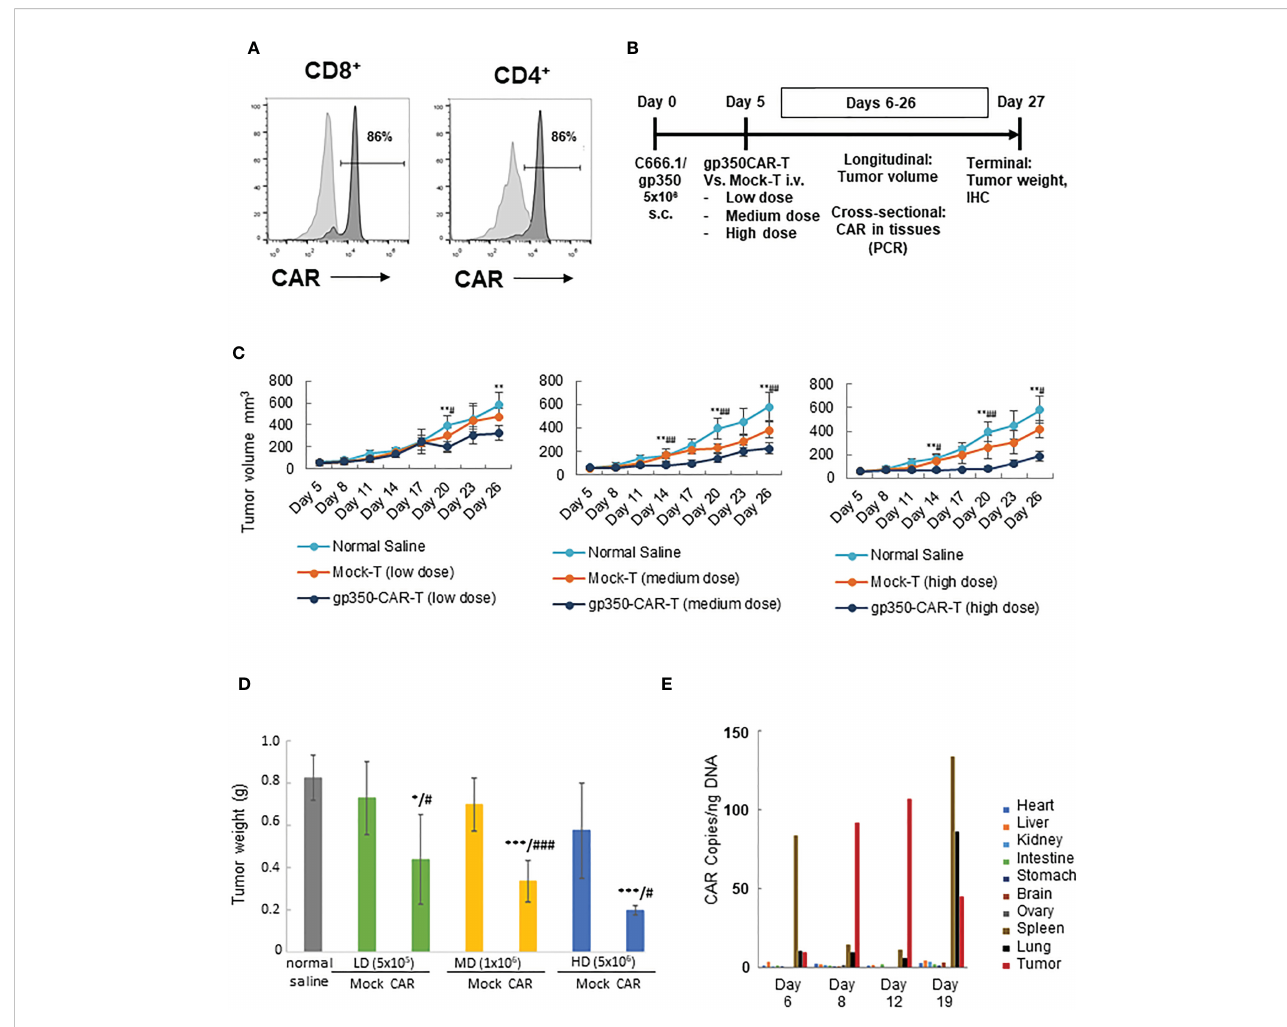
FIGURE 4 In vivo testing of gp350CAR-T cells in B-NDG mice challenged with NPC. (A) Flow cytometry analyses of GMP-like gp350CAR-T cells used for in vivo experiments showing high frequencies of gp350CAR + CD8 + and CD4 + T cells. (B) Schematic representation of in vivo experiment. Mice were injected with 5x10 6 NPC EBV + C666.1/gp350 cells s.c. Five days later, mice were injected with saline, mock-T or CAR-T cells at escalating cell doses. Longitudinal, cross-sectional and terminal analyses were performed to follow tumor growth, CAR-T cell bio-distribution and therapeutic speci fi city. (C) Longitudinal analyses of tumor volume (mm 3 ). Left graph: low T cell dose (5x10 5 ); middle graph: medium T cell dose (1x10 6 ); right graph: high T cell dose (5x10 6 ). (D) Terminal analyses of tumor weight (g). Grey: saline control; green: low T cell dose; yellow: medium T cell dose; blue: high T cell dose. (E)